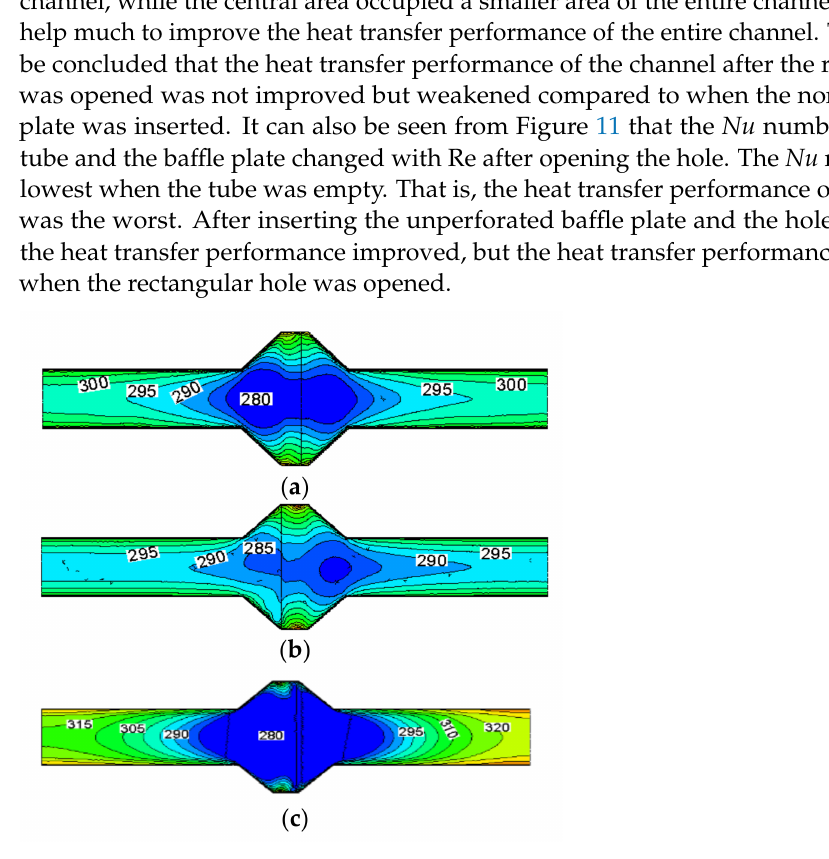
Figure 10. Temperature distribution at the center section of the X-axis under three conditions when Re = 27,900. ( a ) BP case; ( b ) one-circle case; ( c ) one rectangle